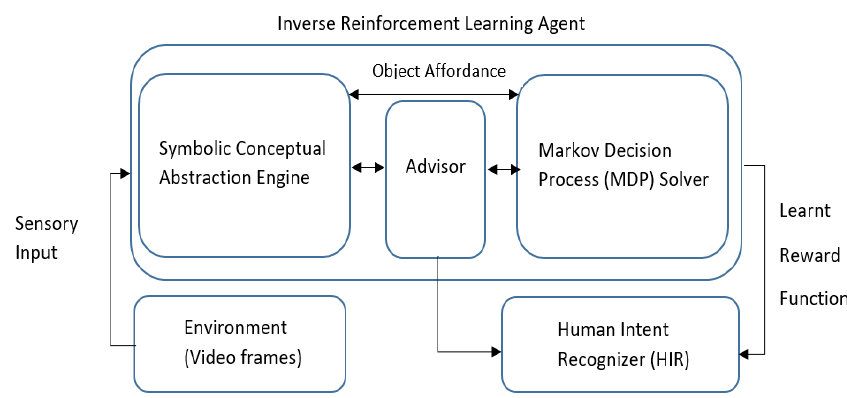
Figure 1: Architecture for human IR consisting of a novel pipeline for the IRL agent.